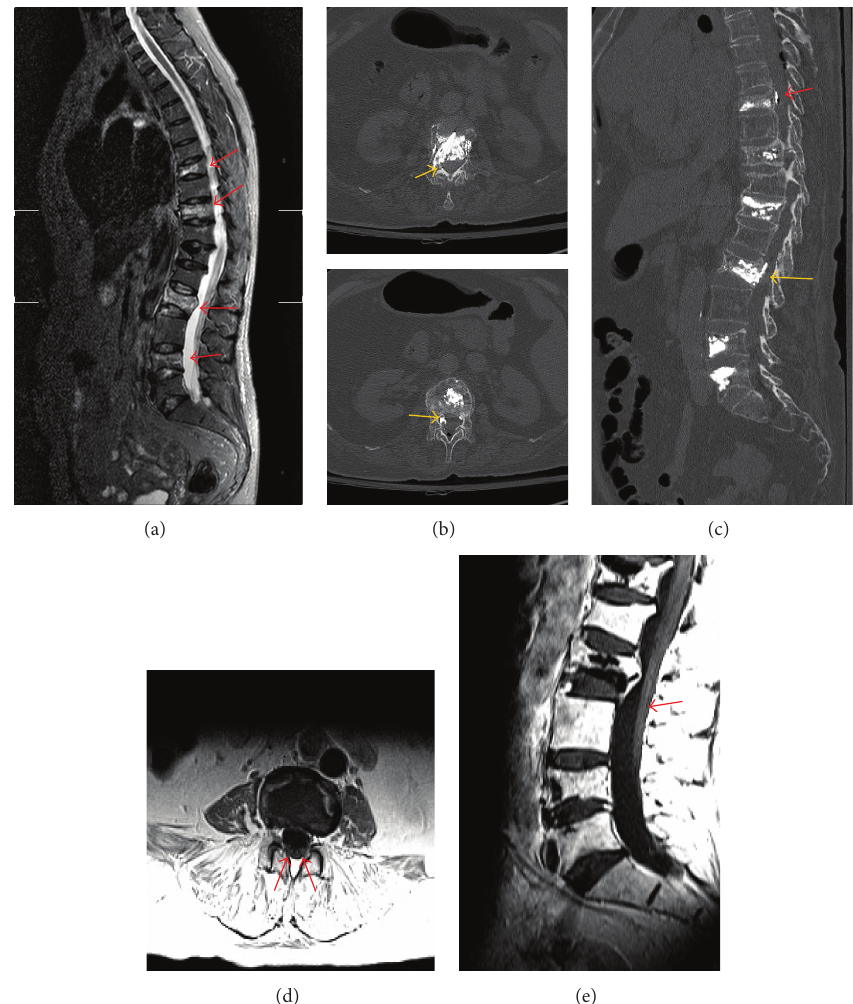
Figure 1: (a) Preinterventional STIR MRI showing acute D8, D10, L2, and L4 vertebral body fracture (red arrows). (b) Postoperative axial CT scan showing epidural cement leakage into the right epidural space at the L2 vertebral level (yellow arrows). (c) Postoperative sagittal CT scan showing epidural cement leakage into the right epidural space at the L2 vertebral level (yellow arrow). Minimal leakage is seen at T8 level (red arrow). (d) Postoperative axial T1, (e) sagittal T1 contrast MRI, showing enhancement of nerve roots along cauda equina (red arrows), signalling meningeal